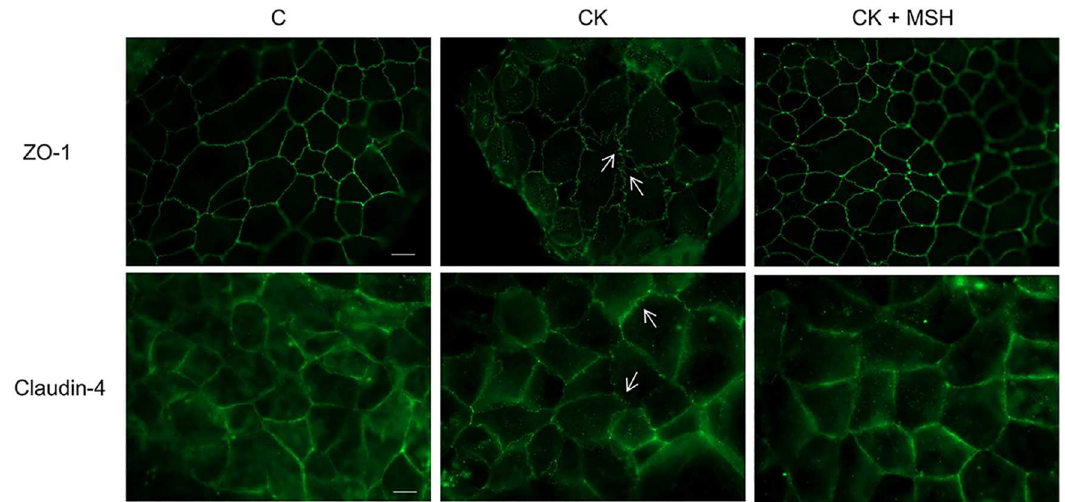
Fig 4. The effect of α -MSH treatment on the immunostaining of tight juntion proteins claudin-4 and ZO-1 in cytokine treated Caco-2 cells. Caco-2 cells were treated with cytokines (CK; 50 ng/ml TNF- α and 25 ng/ml IL-1 β ) without or with 10 − 8 M α -MSH (CK+MSH) for 24 hours, then immunostained for integralmembranetight junction protein claudin-4 and cytoplasmic linkerprotein ZO-1. The control group (C) receivedculture medium. The fluorescent microscopyimages demonstrate the expressionand organizationof the junctionalproteins. Scale bar: 10 μ m.